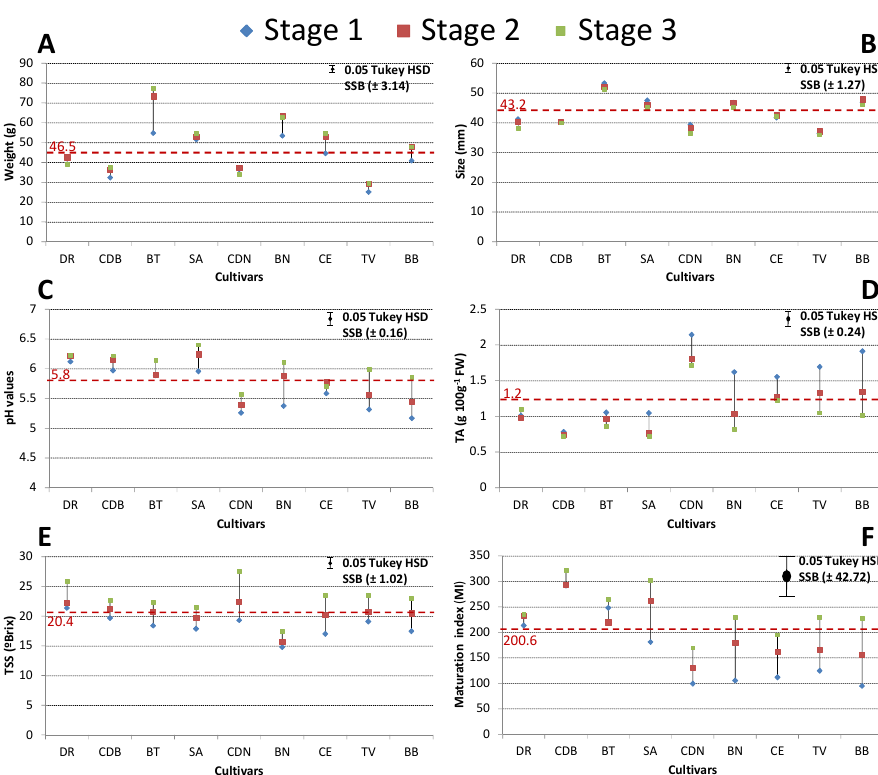
Figure 1. Physicochemical parameters of the fig cultivars at the three ripening stages studied. Weight ( A ); size ( B ); pH ( C ); titratable acidity (TA) ( D ); total soluble solids (TSS) ( E ); maturation index (MI) (TSS/TA) ( F ). SA, San Antonio; BB, Blanca Bétera; BT, Brown Turkey; TV, Tres Voltas L’Any; BN, Banane; CDB, Cuello Dama Blanco; CDN, Cuello Dama Negro; CE, Colar Elche; DR, De Rey. Tukey HSD, Tukey’s honestly significant differences; SSB, Statistical significance bar.